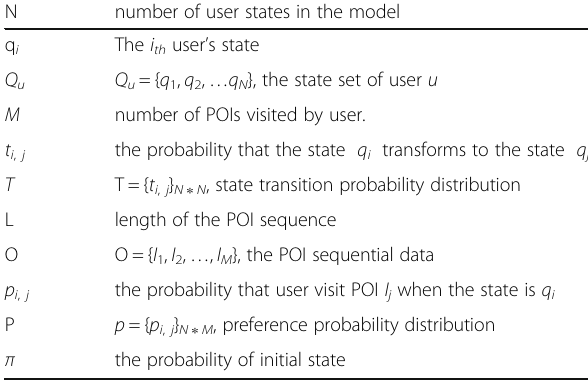
Table 1 Parameters definitions N number of user states in the